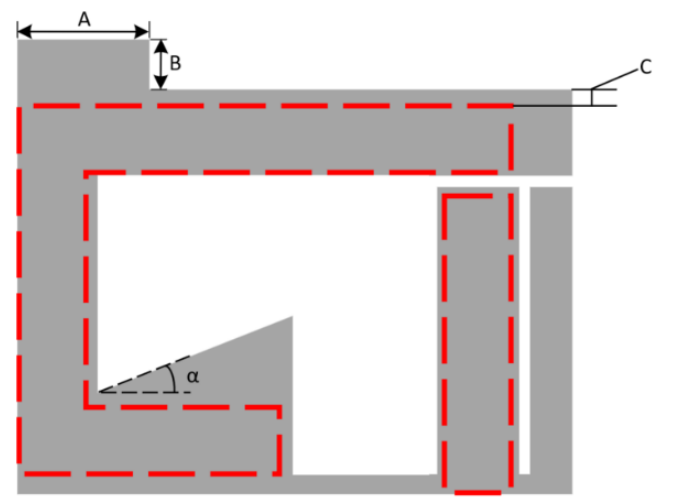
Figure 11. Tuneable substrate